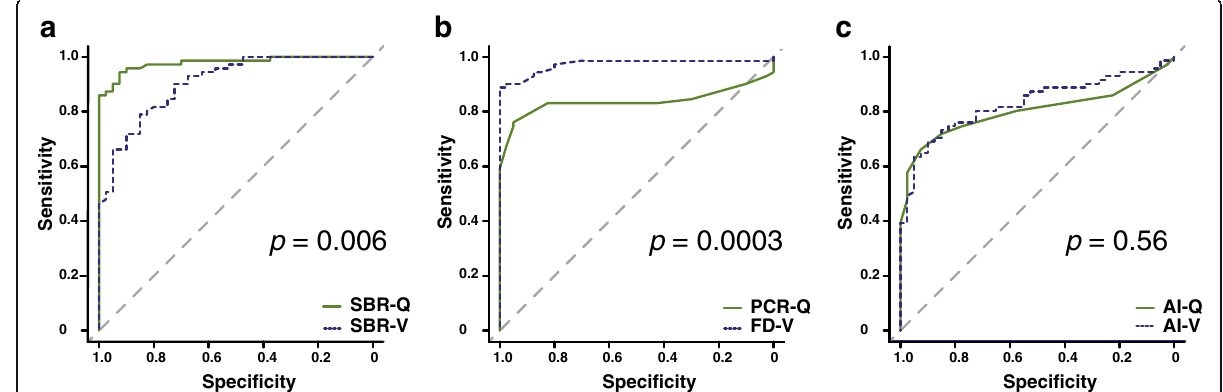
Fig. 3 ROC analysis of the three types of indices. a The AUCs for SBR-Q and SBR-V were 0.978 and 0.906, respectively. b The AUCs for PCR-Q and FD-V were 0.837 and 0.972, respectively. c The AUCs for AI-Q and AI-V were 0.802 and 0.829, respectively. Abbreviations: AI, asymmetry index; AUC, area under the curve; FD, fractal dimension; PCR, putamen-to-caudate ratio; ROC, receiver-operating characteristics; SBR, specific